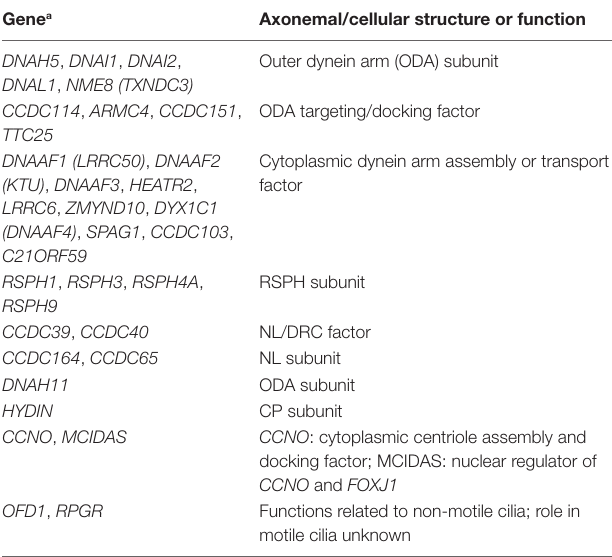
TABLe 1 | Genes associated with primary ciliary dyskinesia and corresponding ultrastructure. Gene a Axonemal/cellular structure or function